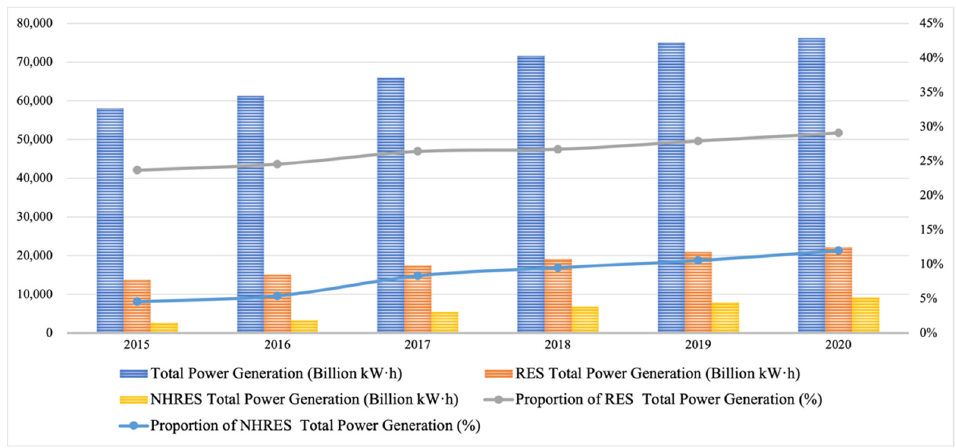
Figure 2. Total power generation, RES, and NHRES power generation and their respective shares. Table 1. Typical documents and differences in the process of renewable energy policy